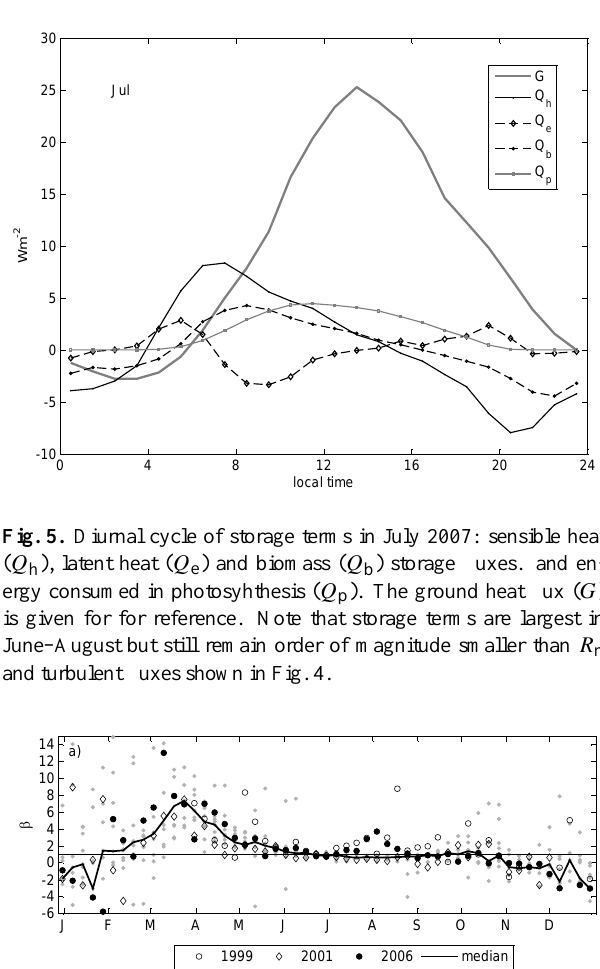
Fig. 4. Diurnal cycles of the main energy balance components on monthly basis during a typical year (2007). Net radiation ( R n ), sen- sible ( H ) and latent heat fluxes (LE) and soil heat flux ( G ). Note varying y-axis between sub-figures.